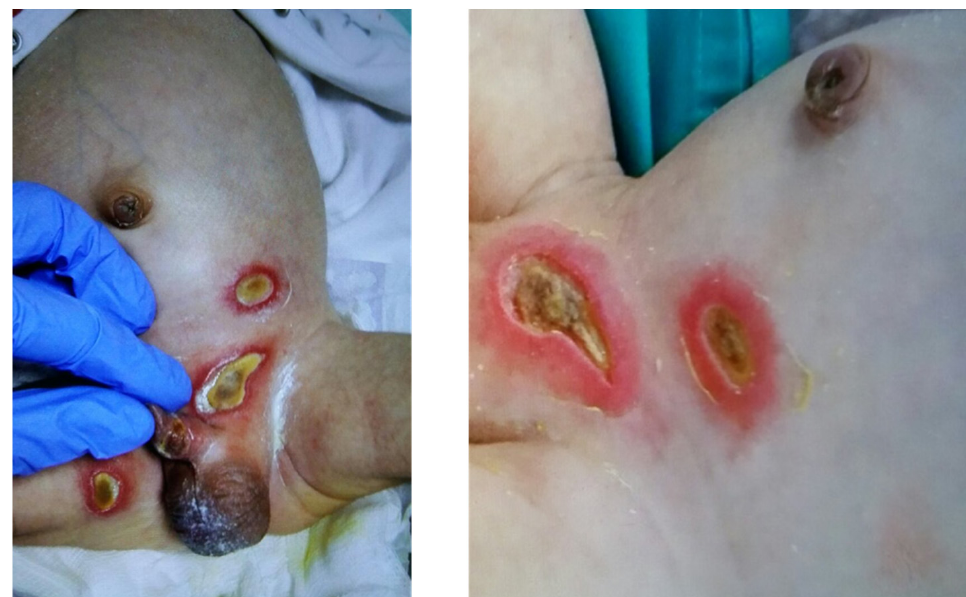
Figure 2. Clinical signs. Lesions of the skin and mucosa without pus formation in a patient with severe LAD I.